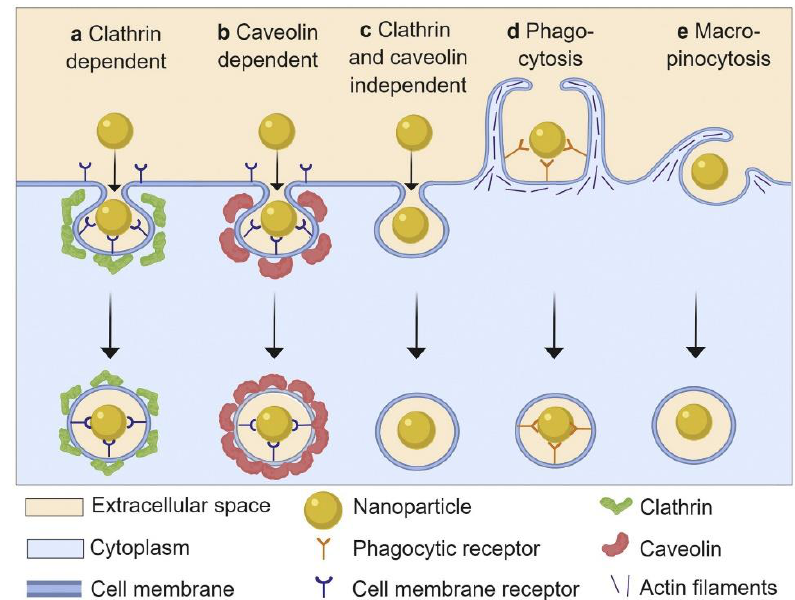
Figure 8. Schematic representation of basic nanoparticle uptake pathways. Reprinted with permission from [109]. Copyright (2019) Elsevier B.V.